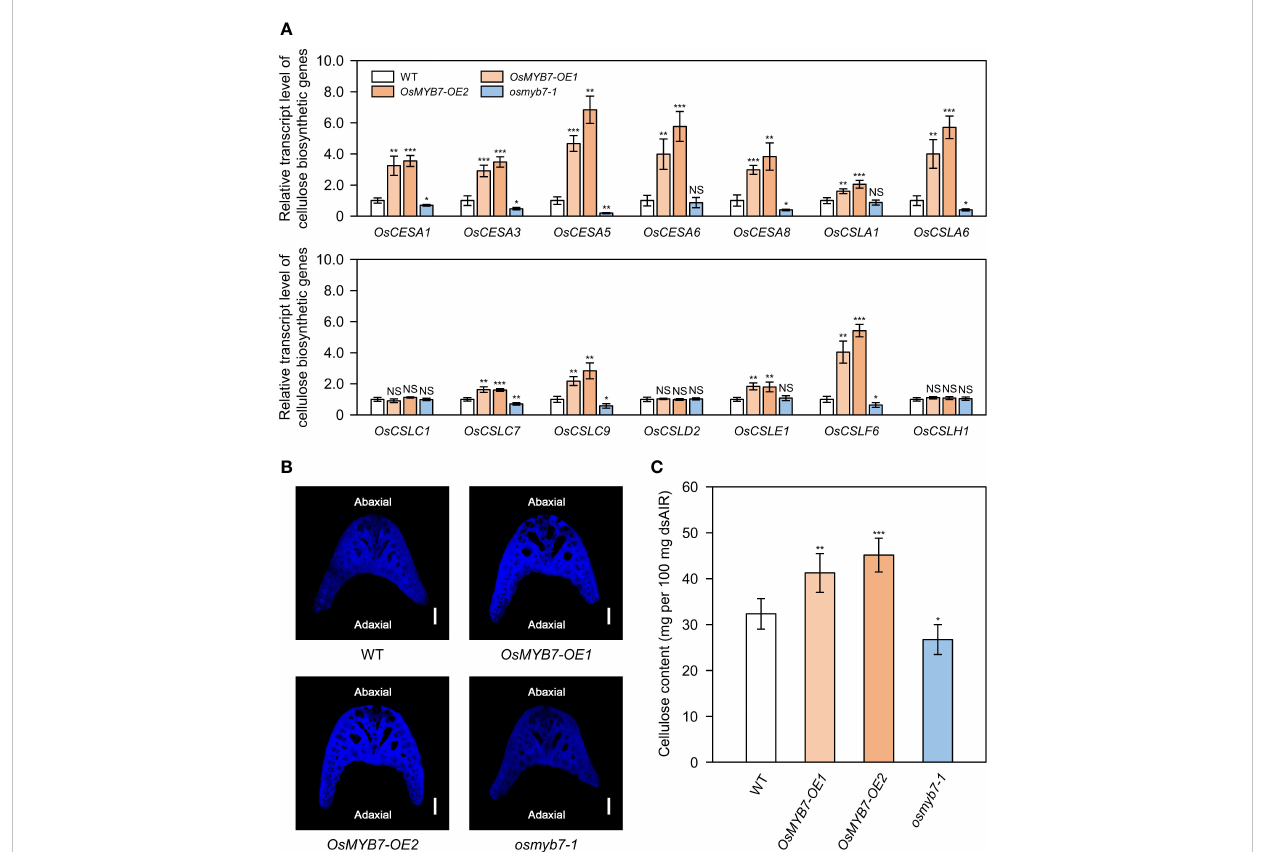
FIGURE 5 OsMYB7 is a positive regulator of cellulose biosynthesis at the lamina joint. (A) Relative transcript levels of cellulose biosynthetic genes in WT, OsMYB7-OE1 , OsMYB7-OE2 , and osmyb7-1 plants. Samples obtained in Figure 4A were subjected to RT-qPCR analysis. The expression levels of each gene were normalized to those of GAPDH and presented relative to the WT, which was set to 1. Data are presented as means ± SD. Asterisks indicate signi fi cant differences as determined by two-tailed Student ’ s t -test (* P < 0.05, ** P < 0.01, and *** P < 0.001). These experiments were conducted twice yielding similar results. NS, not signi fi cant. (B) Histochemical staining of the lamina joint for cellulose. Lamina joints of fl ag leaves at the S5 stage were collected from WT, OsMYB7-OE1 , OsMYB7-OE2 , and osmyb7-1 plants grown in natural paddy fi eld conditions, and the corresponding transverse sections were subjected to calco fl uor white staining, which visualizes cellulose as bright blue color under UV excitation. Scale: 500 m m. Similar results were obtained in at least three independent samples. (C) Determination of cellulose contents in lamina joints of WT, OsMYB7-OE1 , OsMYB7-OE2 , and osmyb7-1 plants. Flag leaf lamina joints from plants at the ripening stage (30 DAH) grown under natural day-night conditions in a paddy fi eld were harvested and subjected to anthrone assay, which quanti fi es total cellulose contents colorimetrically. Data are presented as means ± SD from six independent samples (around 50 lamina joints per sample). Asterisks indicate signi fi cant differences as determined by two-tailed Student ’ s t -test (* P < 0.05, ** P < 0.01, and *** P < 0.001). These experiments were repeated twice with similar results. dsAIR, destarched alcohol-insoluble cell wall